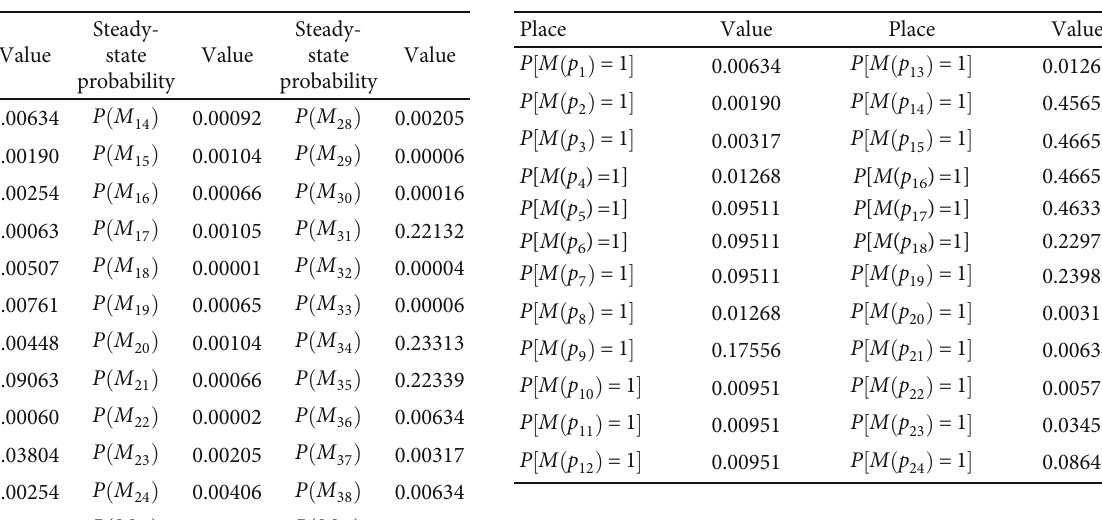
Figure 7: Isomorphic MC equivalents to the SPN model. Table 2: Steady-state probability. Table 3: The busy rate of the places.